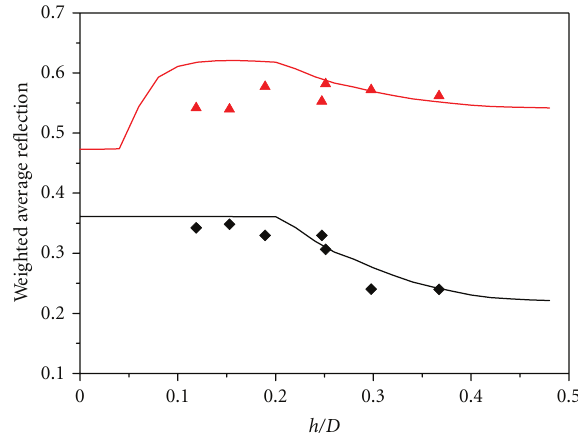
Figure 8: Simulated and measured reflection values graphed as a function of wavelength for two samples with di ff erent h / D values. Reflection values for h / D = 0 . 25 are shown in red with the solid line and (red triangle) symbols denoting the simulated and measured values, respectively. Reflection values for h / D = 0 . 37 are shown in black with the solid line and ( ♦ ) symbols denoting the simulated and measured values, respectively.